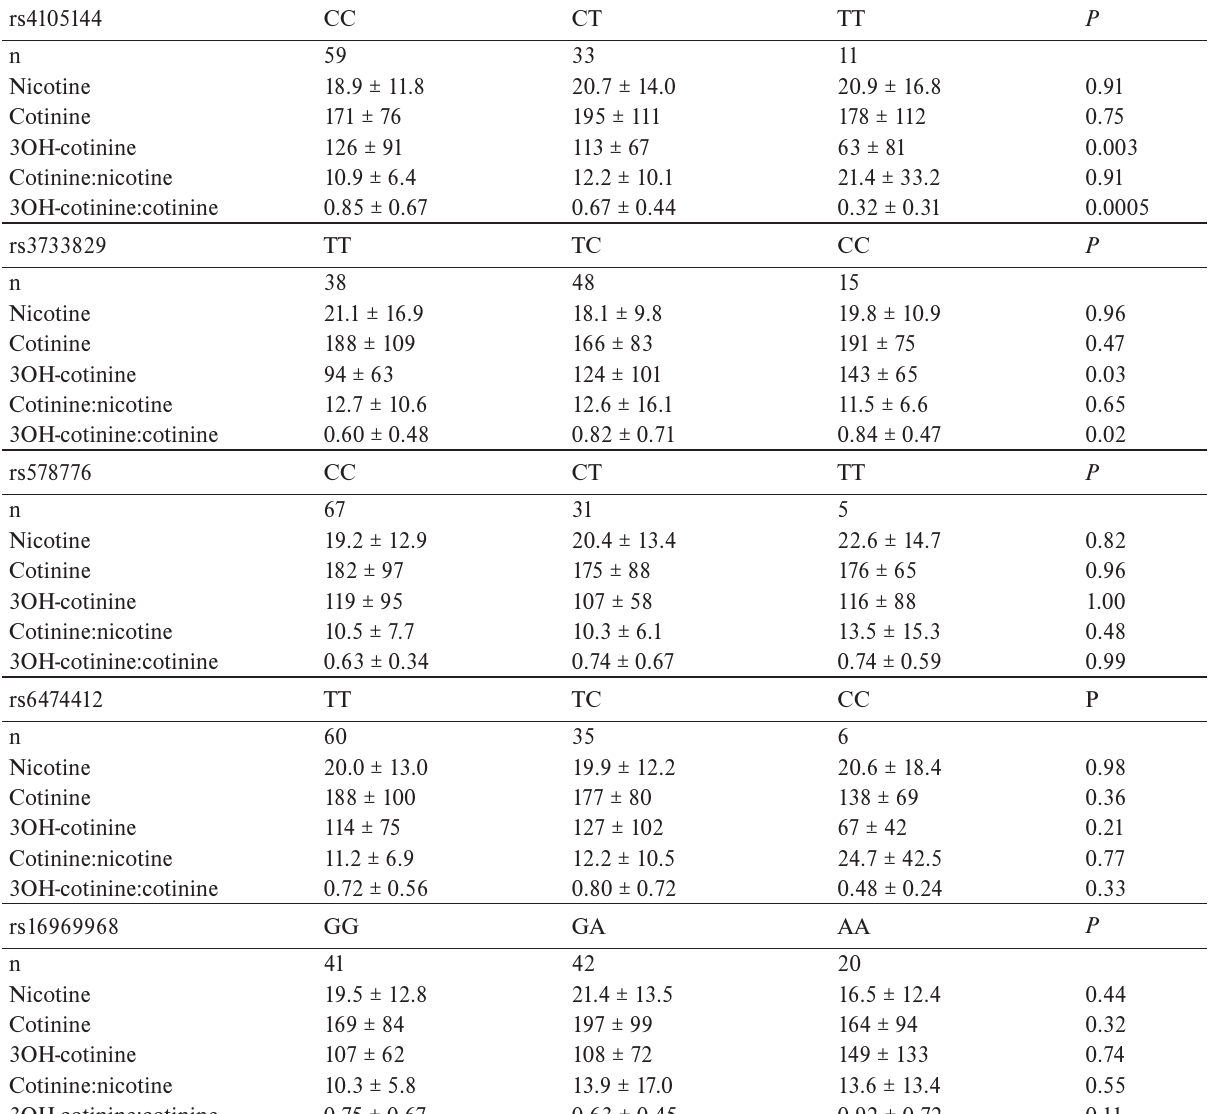
Table 2. Plasma concentrations of nicotine metabolites according to the individual genotypes of analysed